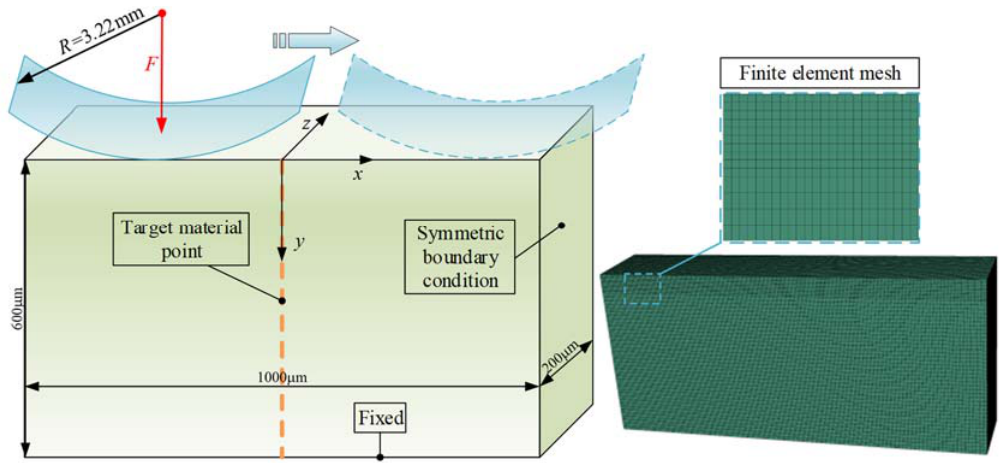
Figure 12. The contact model of the crankshaft and the cylindrical roller bearing.